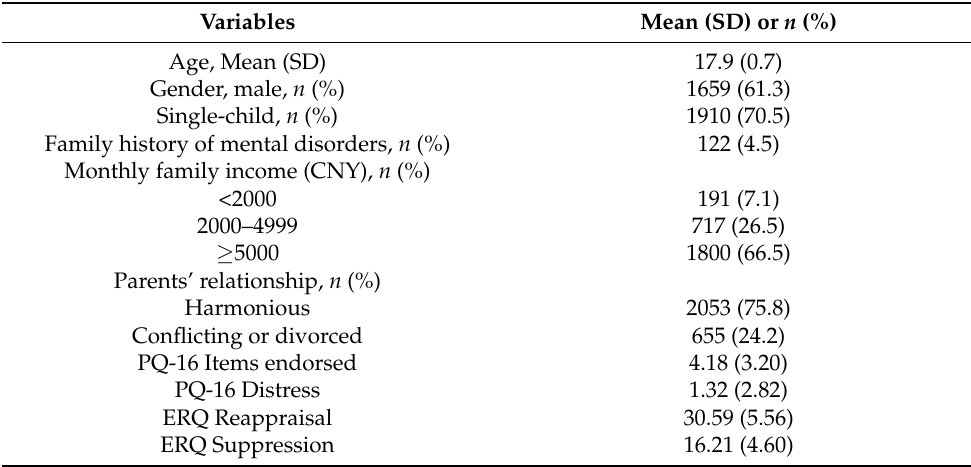
Table 1. Sample characteristics.